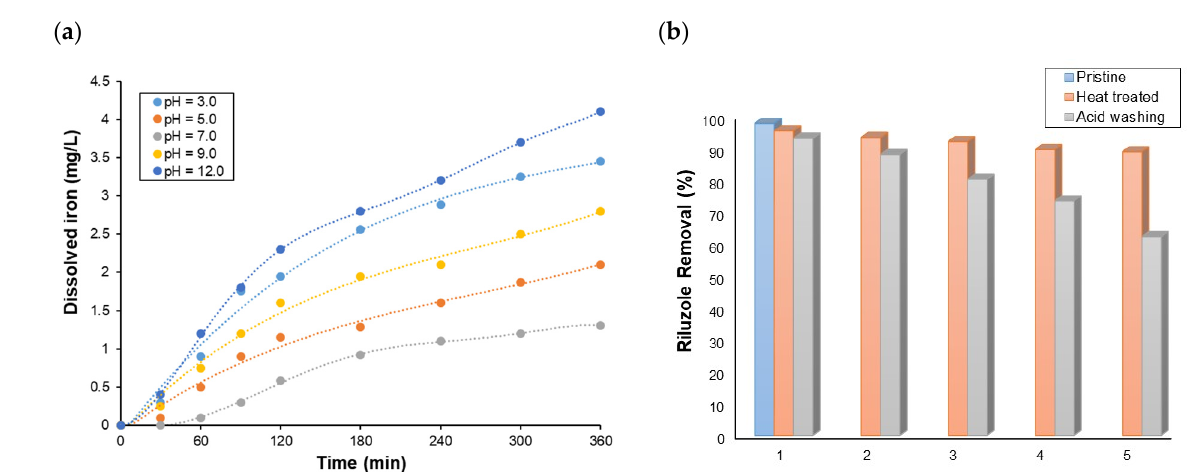
Figure 7. ( a ) Changes of dissolved iron with time at different pH values, ( b ) riluzole removal yield using pristine, heat-treated, and acid-washed catalyst after cycles 1–5 at pH 3.0 during the treatment of 23.4 mg/L riluzole aqueous solutions by Fe-based catalyst/H 2 O 2 . Experimental conditions: H 2 O 2 : 1000 mg/L, Fe-based catalyst: 200 mg/L (particle size < 200 µm), Temperature: 23–25 °C, Mixing rate: 400 rpm.